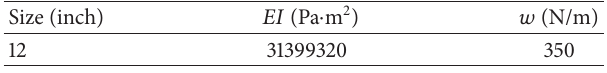
Table 1: Basic values of the pipeline in the example.